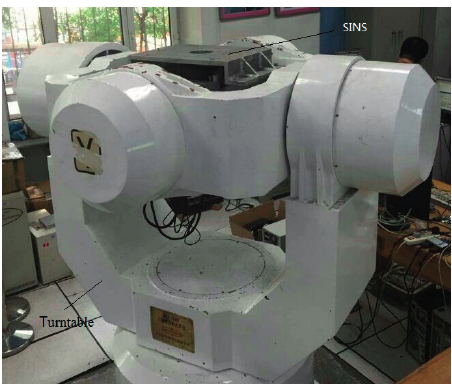
Figure 11. High-precision, three-axis turntable and